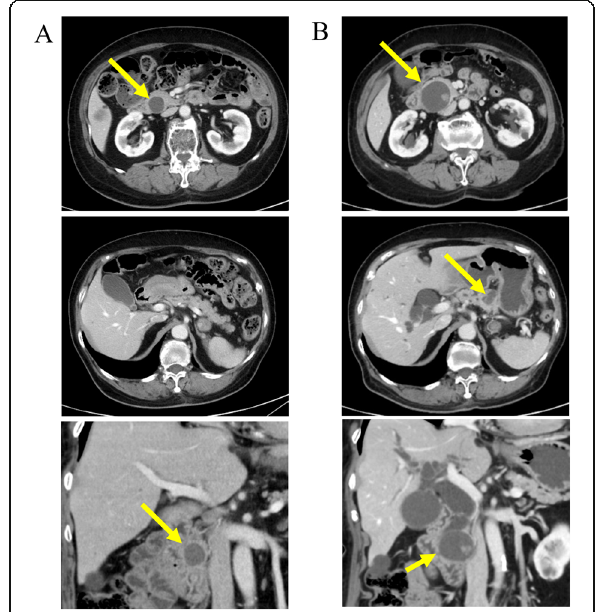
Fig. 1 Enhanced computed tomography findings. a CT findings at 1 year after lobectomy for primary lung cancer. A 20-mm cystic tumor was detected on the pancreatic head, with no tumor on the pancreatic body. b CT findings at 2 year after lobectomy. The cystic tumor on the pancreatic head gradually increased from 20 mm to 37 mm and showed a contrasted solid nodule inside the cystic tumor. The cystic tumor was also indicated at the pancreatic body